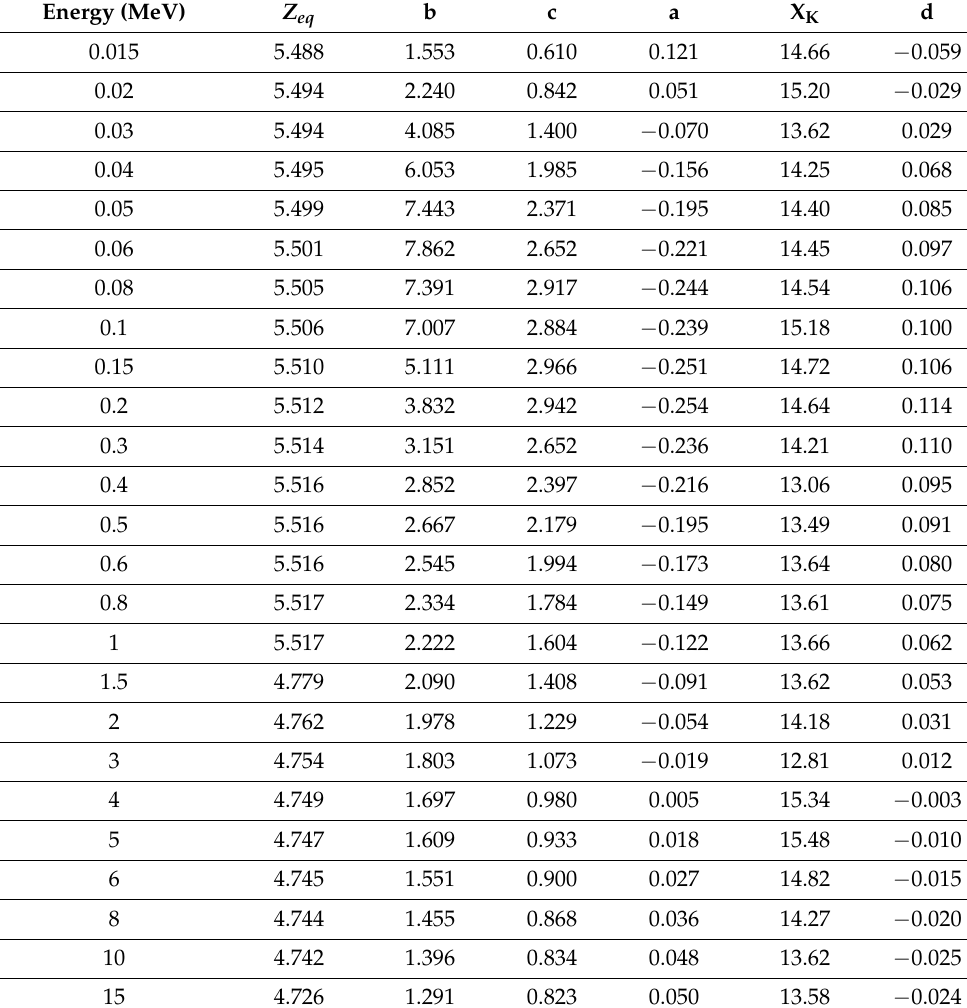
Table 1. The ( Z eq ) and GP fitting parameters for PMP (C 6 H 12 ) in the range 0.015–15 MeV. Energy (MeV) Z